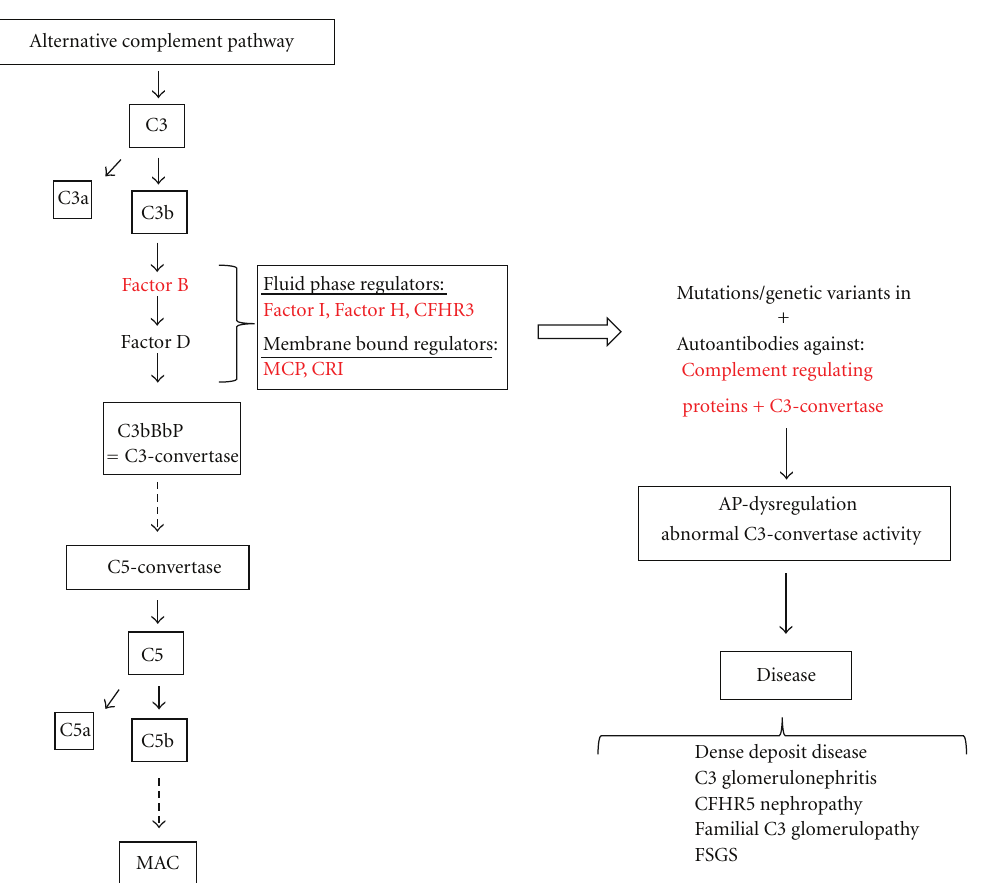
Figure 1: Dysregulation of the alternative complement cascade due to acquired or genetic factors leads to defective complement control causing a range of complement-associated glomerulopathies. C3 is cleaved to generate C3a and C3b. After binding of C3b to factor B, the complex is cleaved by factor D to form C3-convertase. The initial convertase constantly cleaves C3 at a low rate (referred to as “tick-over” of the alternative pathway). Binding of another C3b-fragment to C3-convertase creates a C5-convertase after which the pathway proceeds in the same manner as the classical pathway recruiting additional complement factors to ultimately form the membrane attack complex (MAC). The alternative pathway is strictly regulated by complement regulating proteins (listed in red). Mutations, genetic variations, or antibodies against complement regulating proteins or C3-convertase lead to abnormal C3-convertase activity. The subsequent deposition of activated complement products causes a range of complement-associated glomerulopathies. Abbreviations: C3; complement component 3, CFHR3; complement factor H related protein, AP; alternative